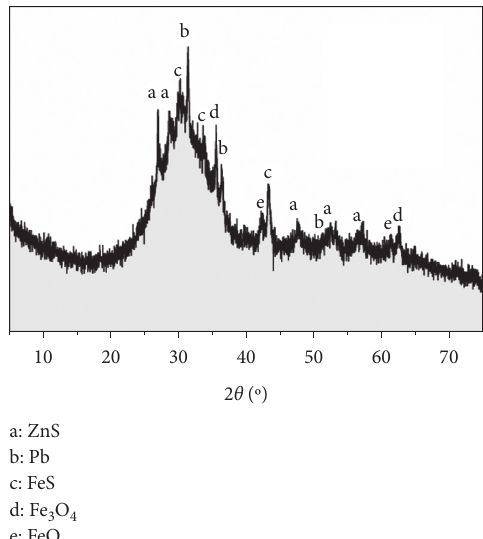
Figure 6: XRD pattern of lead-zinc slag.